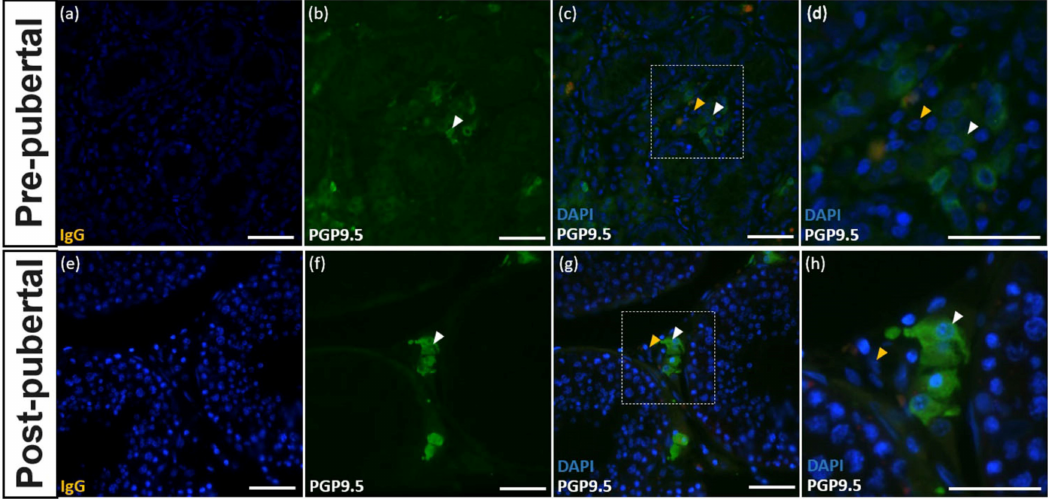
Figure 5. Expression of PGP9.5 in Leydig cells of pre- and post-pubertal donkeys. Testicular tissue stained with IgG showed no immunolabeling ( a , e ). The expression of PGP9.5 was observed in the testes of pre-pubertal ( b – d ) and post-pubertal ( f – h ) donkeys. The white arrowheads indicate Leydig cells stained with PGP9.5. The yellow arrowheads indicate Leydig cells without PGP9.5 staining. The white bar = 50 µ